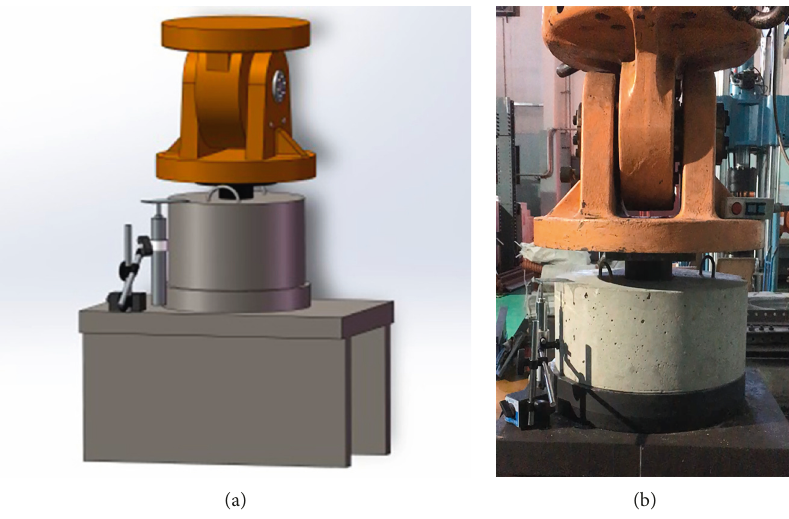
Figure 3: Test setup. (a) Three-dimensional (3D) test diagram. (b) Test machine.